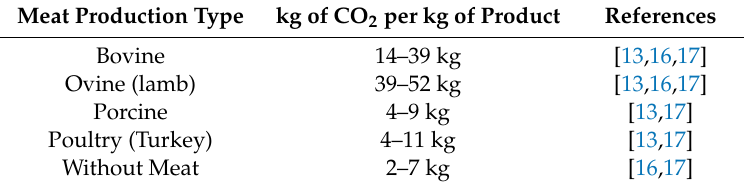
Table 1. CO 2 emissions of major livestock and meat-free products (adapted from Apostolidis and McLeay [13]).